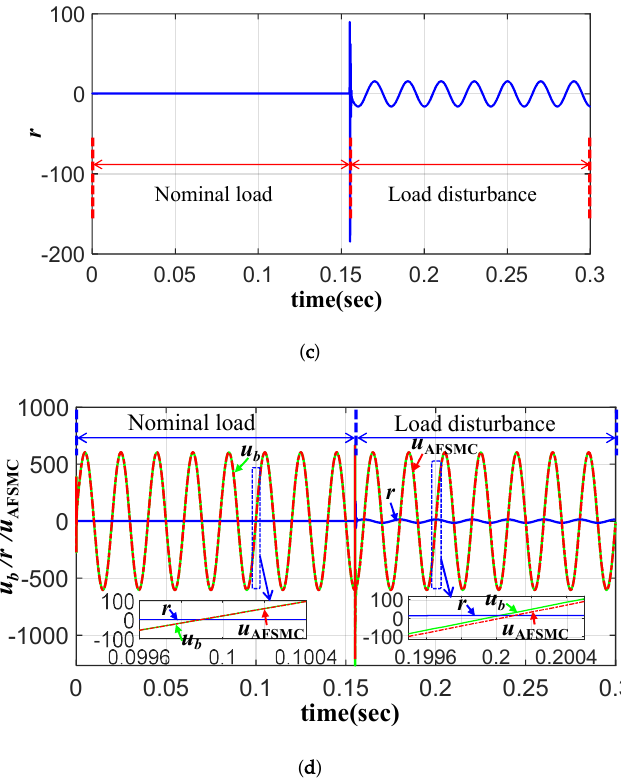
(cid:12) (cid:12) i = 1,2,3 ); ( b ) Standard